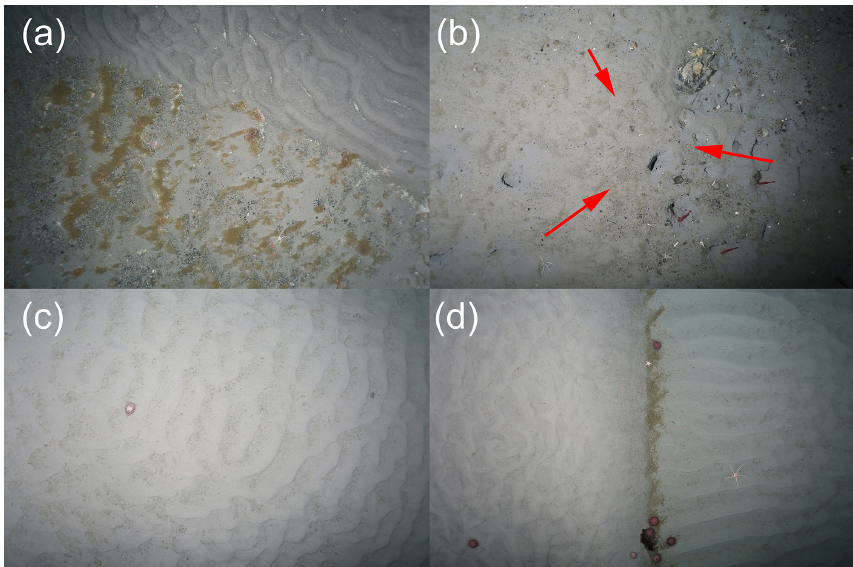
Figure 4. Typical seafloor images collected from each of the OFOBS surveys made of the Weddell Sea Shelf seafloor during RV Po- larstern cruise 124. (a) Station PS124_45-1, SW-RELEASER_2021_02_22 at 04_19_03 IMG_0199.JPG, (b) Station PS124_46-3. HOTKEY_2021_02_22 at 19_24_57 IMG_0056.JPG, (c) Station PS124_47-2, TIMER_2021_02_23 at 03_15_59 IMG_0405.JPG, (d) Sta- tion PS124_47-2, TIMER_2021_02_23 at 03_14_37 IMG_0400-JPG. The three red points within each image represent the sizing lasers (50cm spacing). Red arrows in panel (b) indicate the positions of these three red points. All images are presented here and in the dataset, with no manipulation or colour